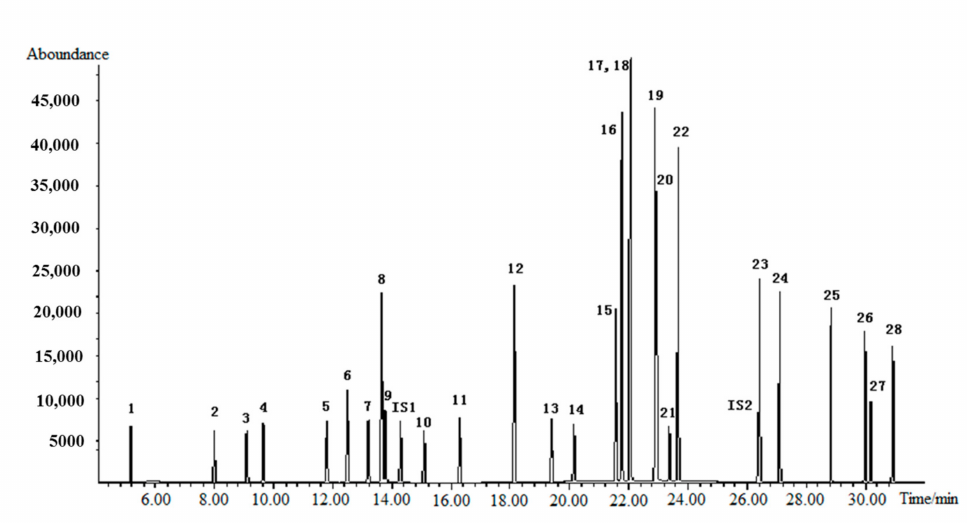
Figure 1. Total ion chromatography of 28 VOCs determined by GC-MS (1. vinyl chloride; 2. 1,1-dichloroethylene; 3. dichloromethane; 4. trans-1,2-dichloroethene; 5. cis-1,2-dichloroethene; 6. trichloromethane; 7. carbon tetrachloride; 8. benzene; 9. 1,2-dichloroethane; 10. trichloroethy- lene; 11. bromodicloromethane; 12. toluene; 13. tetrachloroethylene; 14. chlorodibromomethane; 15. chlorobenzene; 16. ethylbenzene; 17,18. p-xylene/m-xylene; 19. o-xylene; 20. styrene; 21. bro- moform; 22. cumene; 23. 1,4-dichlorobenzene; 24. 1,2-dichlorobenzene; 25. 1,3,5-trichlorobenzene; 26. 1,2,4-trichlorobenzene; 27. hexachloro-1,3-butadiene; 28. 1,2,3-trichlorobenzene; IS1. fluoroben- zene; IS2. 1,4-dichlorobenzene